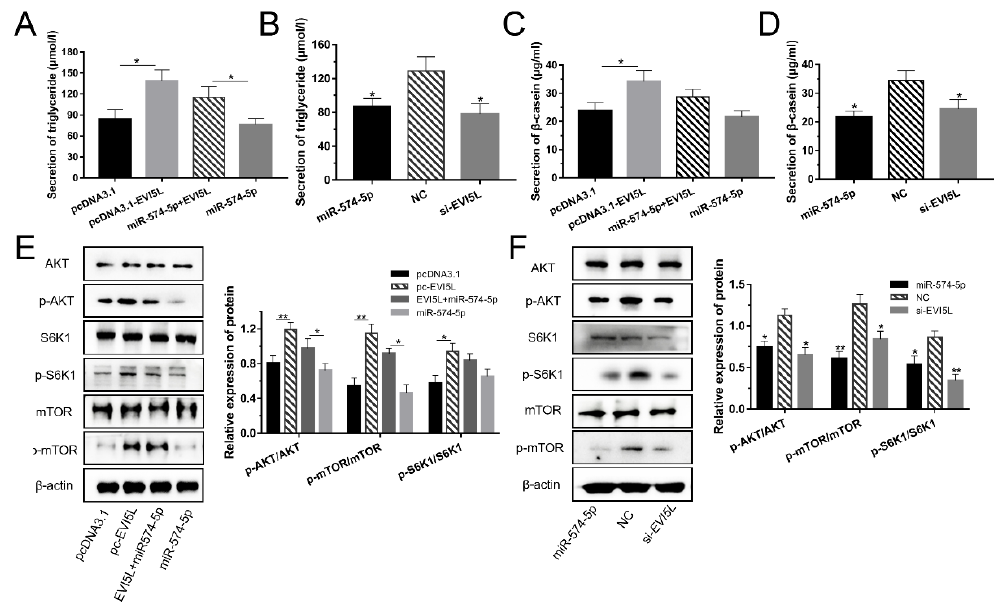
Figure 4. EVI5L increased the milk synthesis in GMECs via the PI3K / AKT–mTOR pathway. ( A , B ) The secretion of triglycerides in GMECs was measured with a detection kit. ( C , D ) The expression of β -casein in the cell-free supernatants by enzyme-linked immunosorbent assay kit. ( E , F ) WB assay was performed to detect the protein expression of the PI3K / AKT–mTOR pathway in GMECs. Pc- EVI5L : overexpression EVI5L plasmid; pcDNA3.1: control group; NC: negative control; si- EVI5L : small interfering RNA; miR-574-5p + EVI5L : miR-574-5p + pcDNA3.1- EVI5L . ** means significant di ff erence ( p < 0.01), * means significant di ff erence ( p < 0.05).